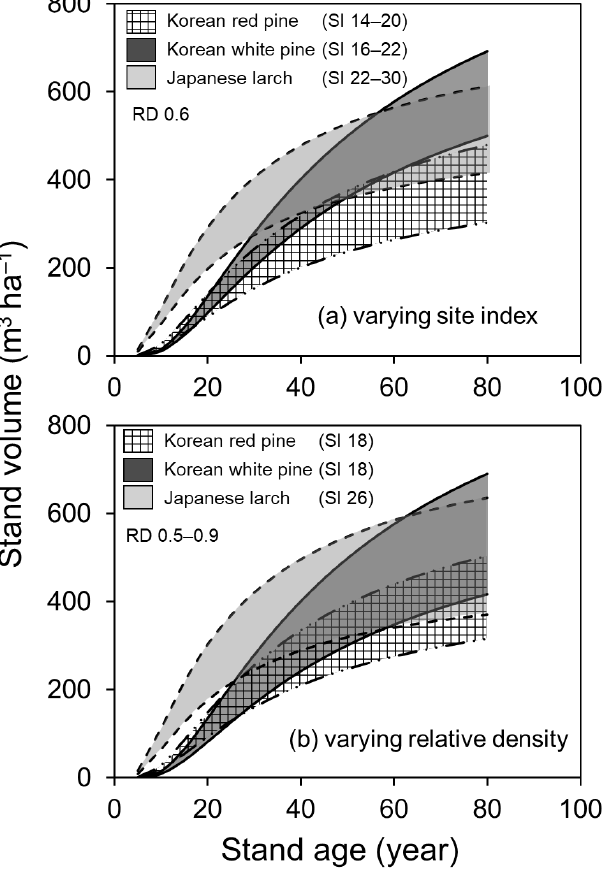
Figure 4. Simulation examples of the variable-density yield models to illustrate the overall range of stand volume by species as a stand develops with stand age. The examples demonstrate the general concept and overall range depending on the site index (plot a ) and the stand density (plot b ). The simulations were performed using Equation (9) with model type 3 based on the fixed-effect param- eters in Table 4. In plot ( a ), the simulation used a varying site index with a moderate level of fixed relative density with a value of 0.6. The representative range for the site index found in this study was applied by species. In plot ( b ), the simulation used a varying relative density with a moderate level for the fixed site index by species. SI: site index. RD: relative